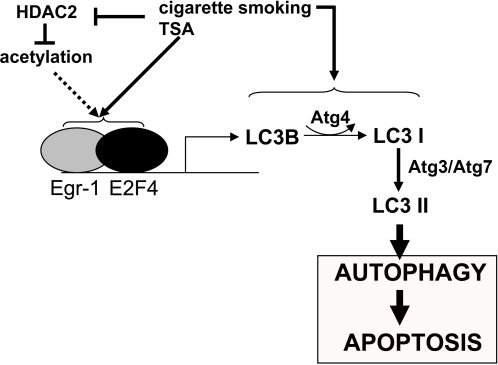
Epigenetic regulation of autophagy by cigarette smoking.The scheme shows the proposed pathway for epigenetic regulation of autophagy by cigarette smoke exposure. Suppression of HDAC activity leads to the increased transcription of the LC3B promoter by E2F/Egr-1 factors.